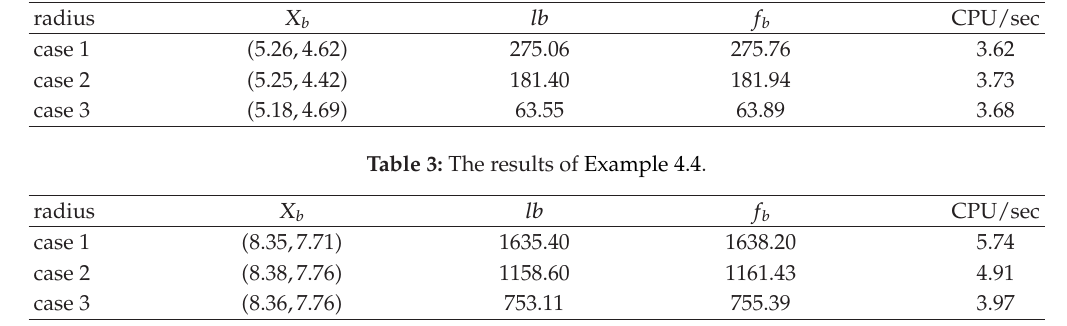
Table 2: The results of Example 4.3.